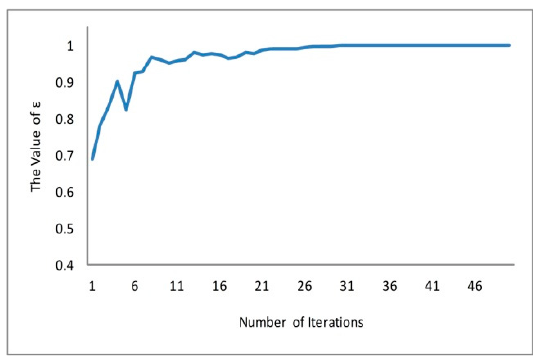
Figure 5. Iterative curve of the algorithm.